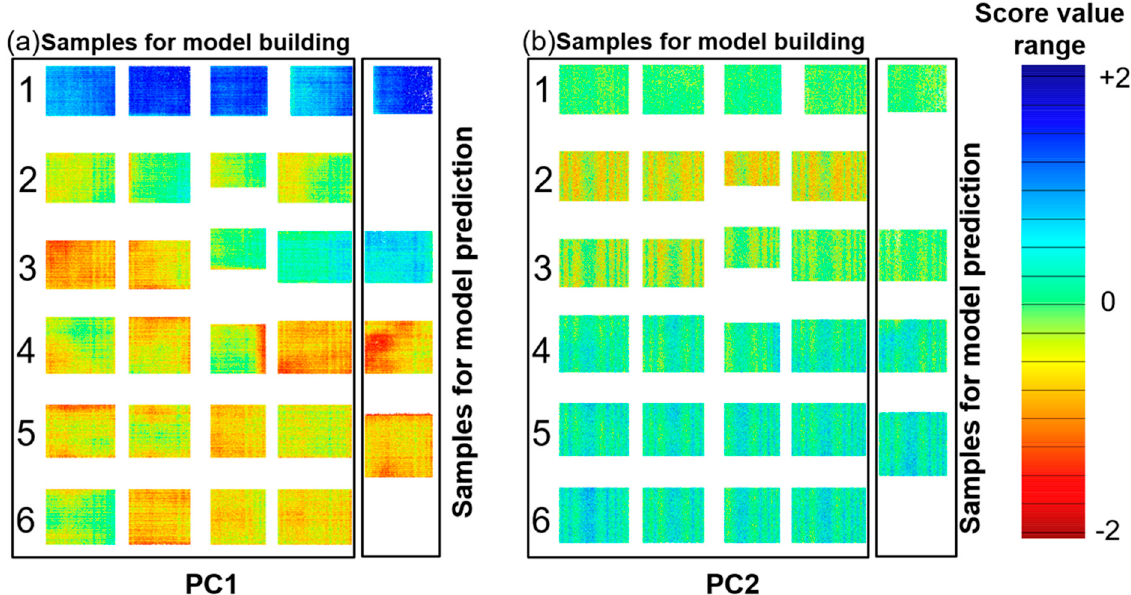
Figure 6. Distribution maps of the oxide layer PC1 ( a ) and PC2 ( b ). Each rectangle represents a single copper sheet. The sample type for each row corresponds to Table 1. The samples are divided into two sets: model building and model prediction for PLS-R. The colored pixels (the score value range) represent the oxide content, from low (blue) to high (red).